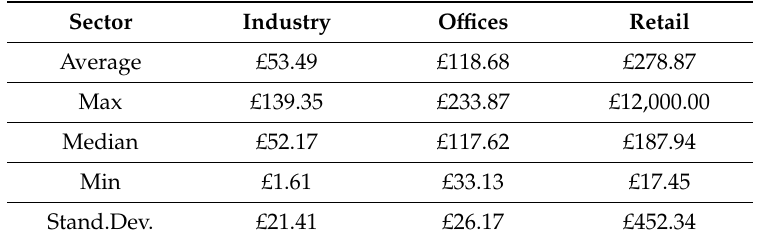
Table 1. RV per m 2 : York, 2019. Sector Industry O ffi